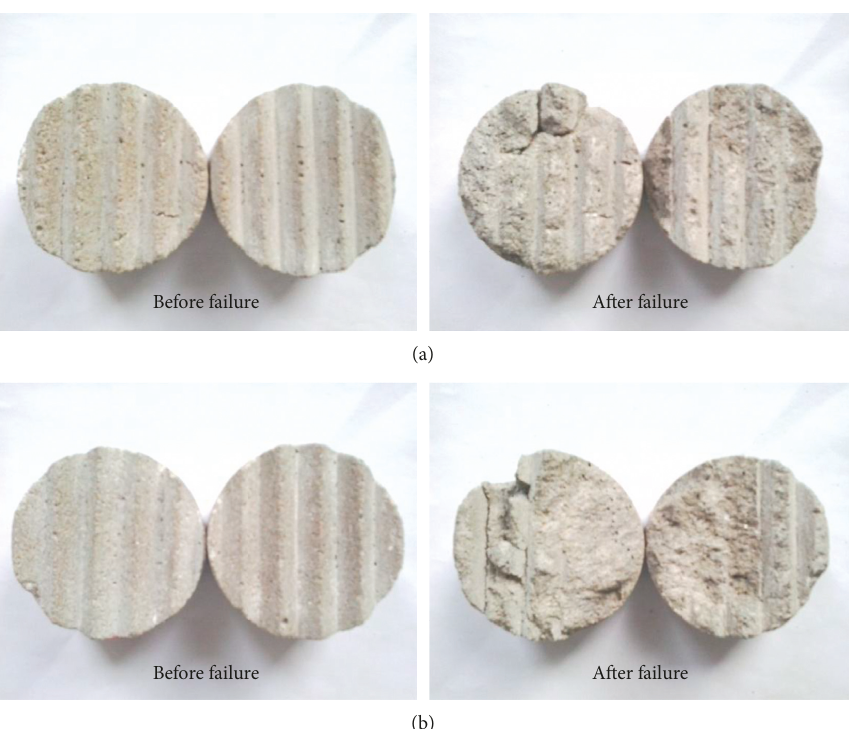
Figure 9: Failure modes of discontinuities based on laboratory experimental results. (a) Failure by sliding over the asperities; (b) failure by shearing through the